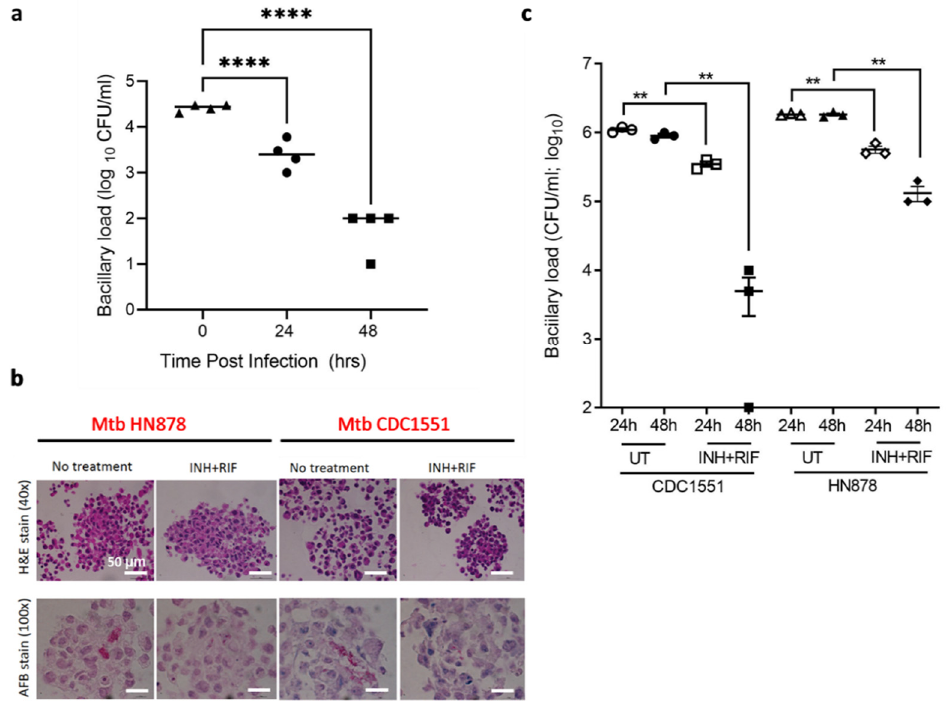
Figure 4. TB spheroids show mycobacterial virulence dependent response to anti-TB drugs ( a ) Estimation of bacterial colony-forming units (CFU/mL) from lysates isolated from PMA-treated TB spheroids infected with BCG mCherry post-treatment with INH and RIF combination at 0, 24 and 48 h time points. ( b ) Images of TB spheroid sections with HN878 and CDC1551 infection, stained with H&E (host cells) and AFB (bacteria). ( c ) CFU/mL determined from TB spheroid infected with clinical isolates Mtb HN878 and CDC1551 and treated with DMSO (UT) and INH+RIF combination. ** p < 0.01; **** p < 0.0001 by one-way ANOVA followed by Tukey’s multiple comparisons test for comparisons of clinical isolates from treated group compared with the respective untreated group. Data and mean from n = 3 wells, comprising of approximately 1200 TB spheroid/well.